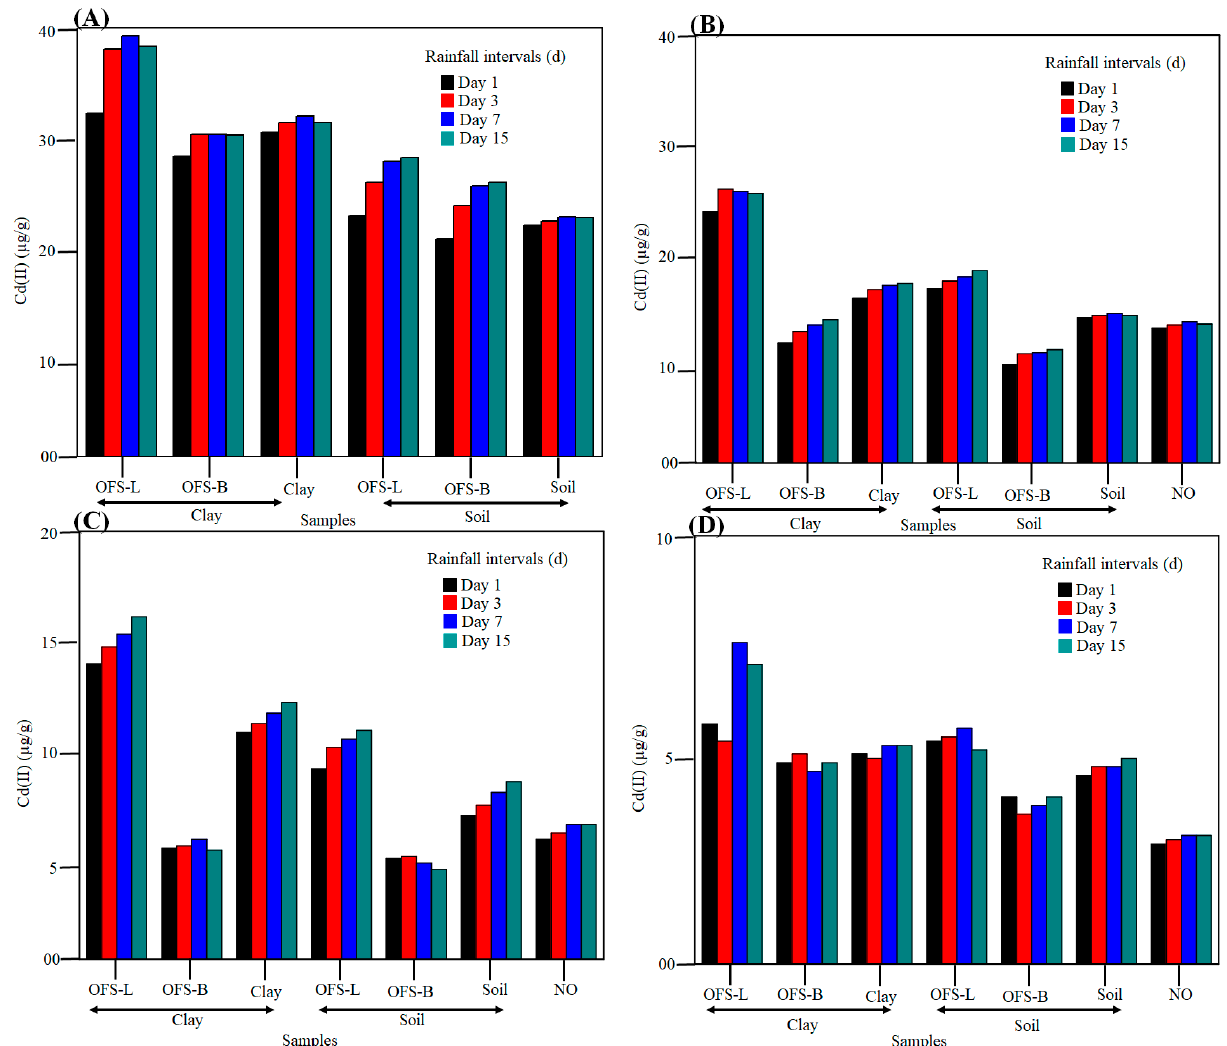
Figure 5. Concentration of Cd (II) in each section of bioretention layer ( A ) additional layer I (1 cm), ( B ) soil layer II (9 cm), ( C ) sand layer III (50 cm), and ( D ) gravel layer IV (5 cm).